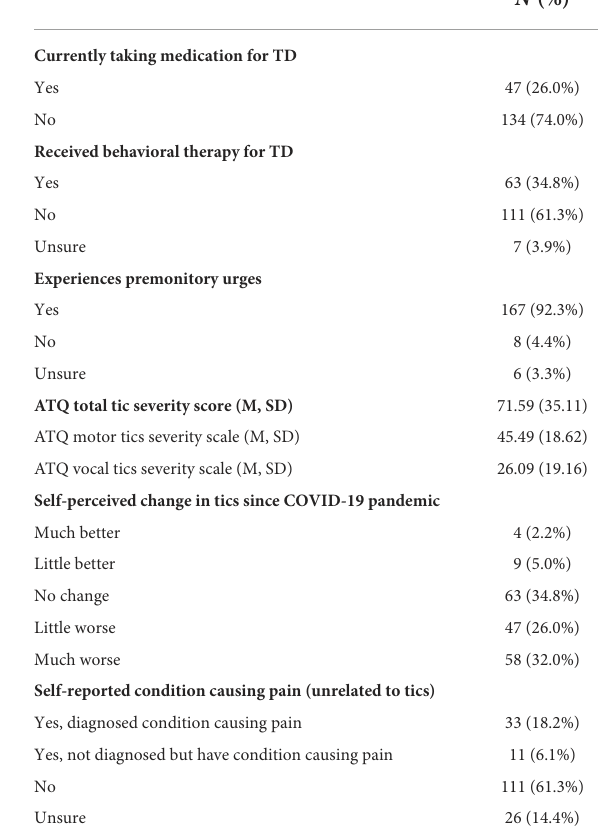
TABLE 1 Demographic characteristics of the sample ( N =